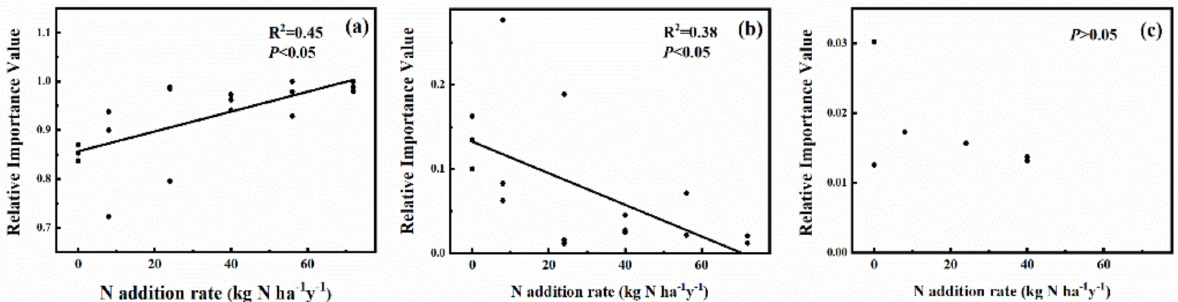
Figure 3. Relationship between functional group importance values and N addition rates: ( a ) grass functional group, ( b ) forb functional group, ( c ) sedge functional group.